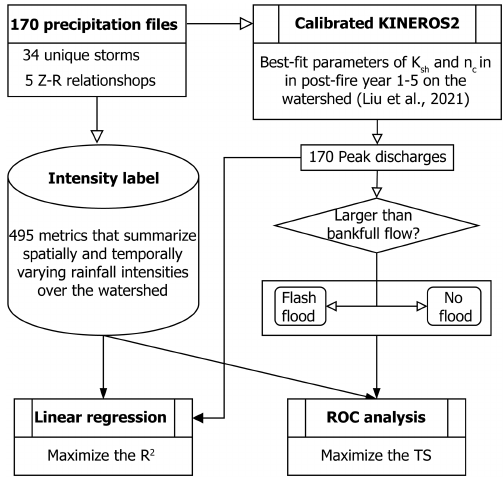
Figure 2. Delineation of rainfall intensity–duration threshold for post-fire flash